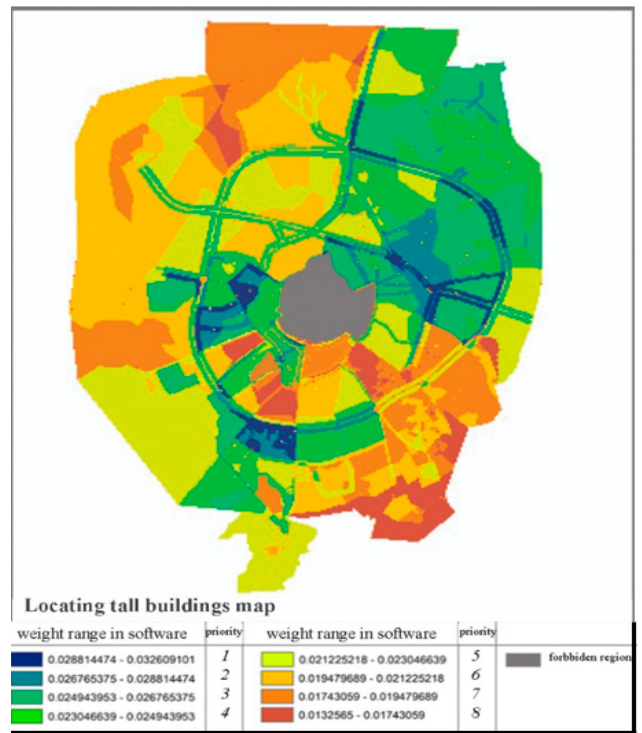
Figure 19. The best urban areas for locating tall buildings. The map shows the priority of suitable places for tall buildings on a scale from dark blue (priority 1) to dark red (priority 8).